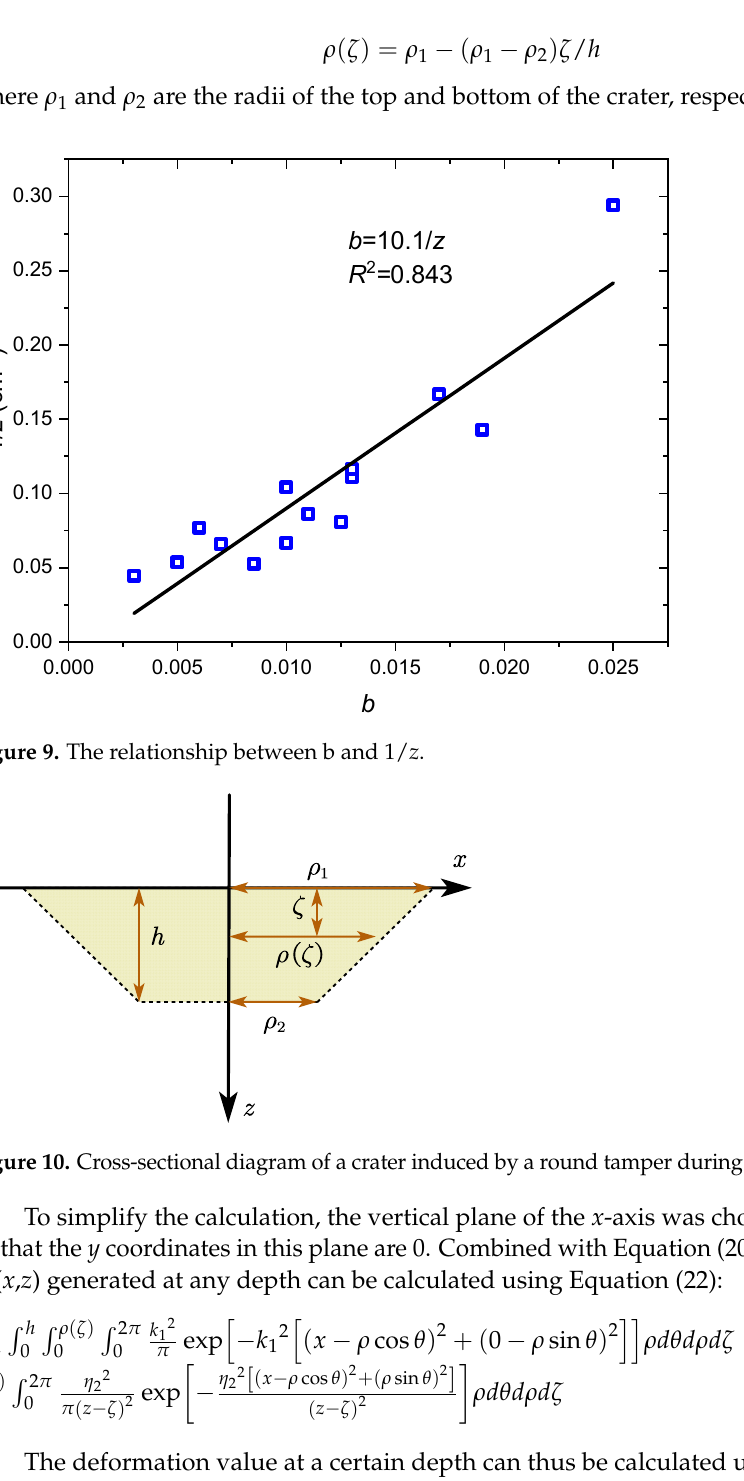
Figure 9. The relationship between b and 1/ z .